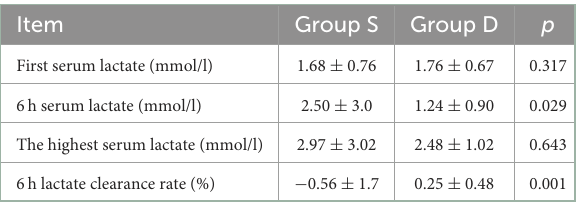
TABLE 2 Comparison of perioperative data between surgery repair group (S group) and transthoracic device closure group (D group) after PSM.